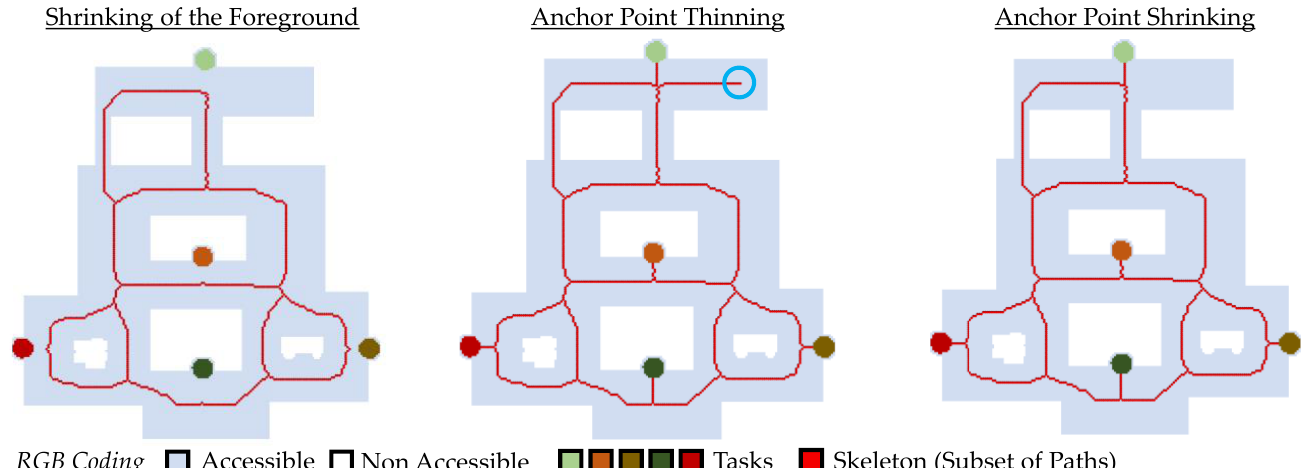
Figure 10. Path generation by homotopic erosion: use of shrinking, anchor point thinning, anchor point shrinking.